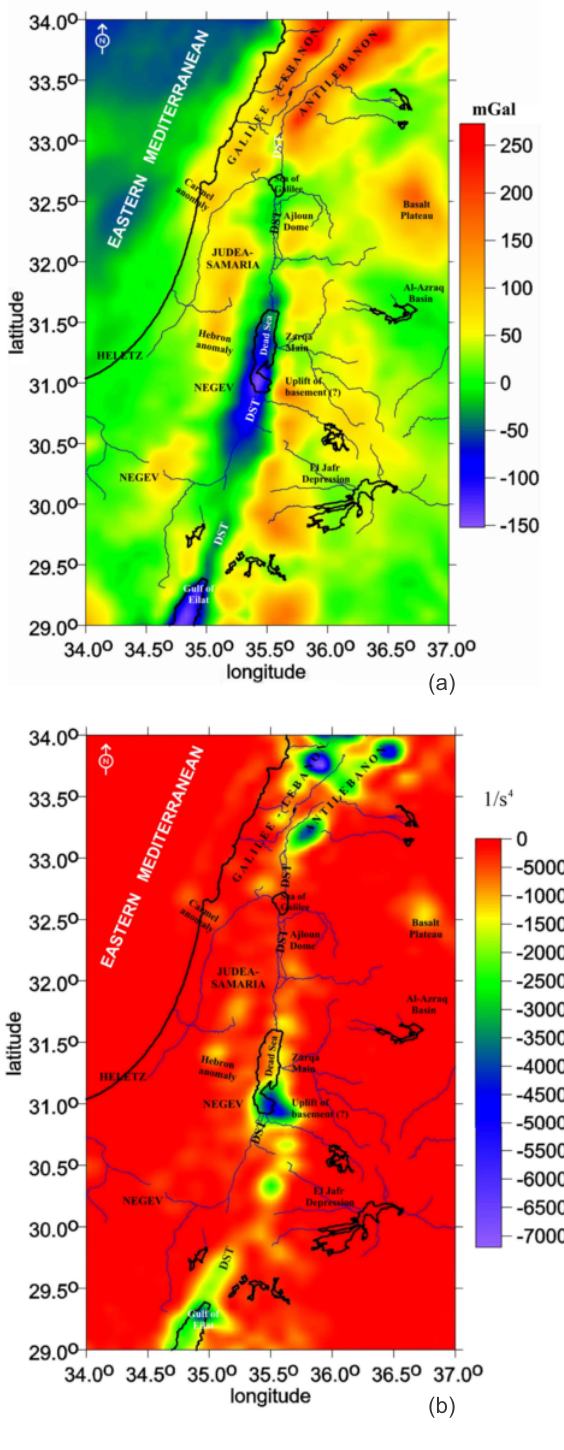
and (c) vd for Israel confirming the structures well-known to geologists and geophysicists. Reproduced from Kloko č ník Figure 6. (a) D g , (b) I 1 et al.